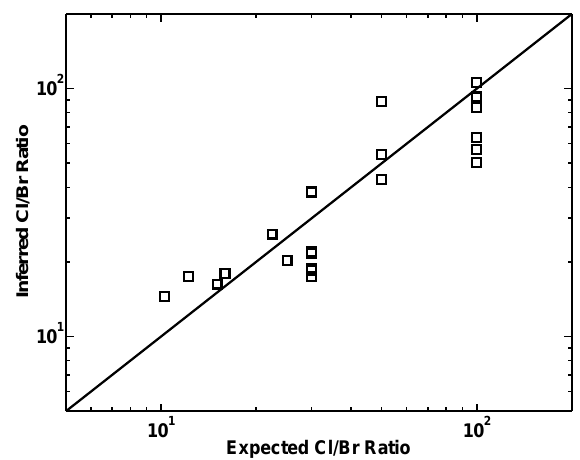
Fig. 7. The Cl:Br ratio in the brine interface layer inferred from our observations (Figs. 3 and 6) is plotted versus Cl:Br ratio predicted from a thermodynamic model of the temperature-dependent brine composition for the conditions tested in our experiment. See text for details. The two estimates are broadly explained by a 1:1 rela- tionship (shown as solid